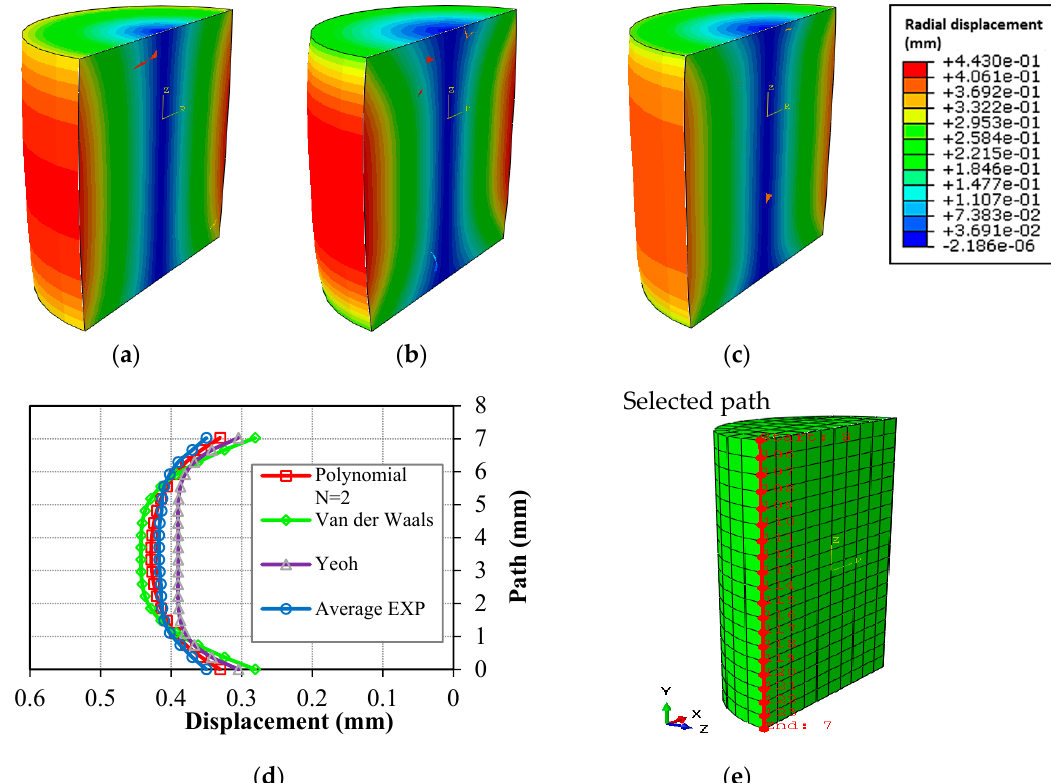
Figure 9. Contour plots of the radial deformation of the FE model incorporating polynomial N = 2 ( a ), Van der Waals ( b ) and Yeoh ( c ) hyperelastic models, and plot of transverse deformation ( d ) of a selected path ( e ) on the FE models.